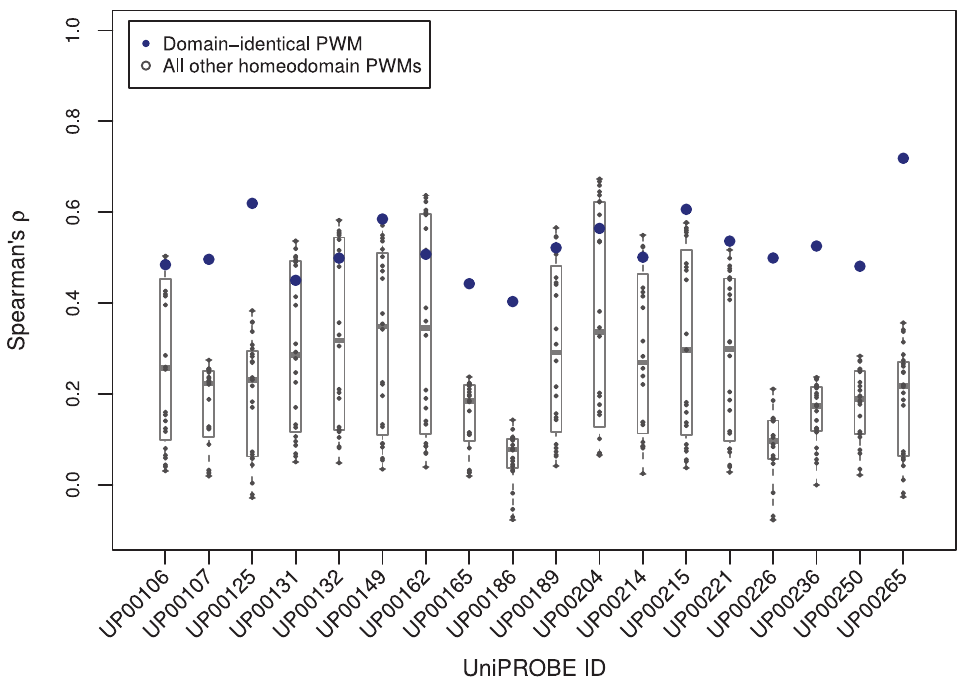
Figure 6. The distribution of Spearman correlation coefficients for the domain-identical PWM and all other PWMs from the same homeodomain family for each TF from the test set in Figure 1. In each case, the correlation coefficient for the domain-identical PWM either clearly outperforms or is in the cluster of top performing PWMs, demonstrating that domain-identical PWMs capture the DNA sequence affinity and specificity of transcription factors better than considering the TF family alone.